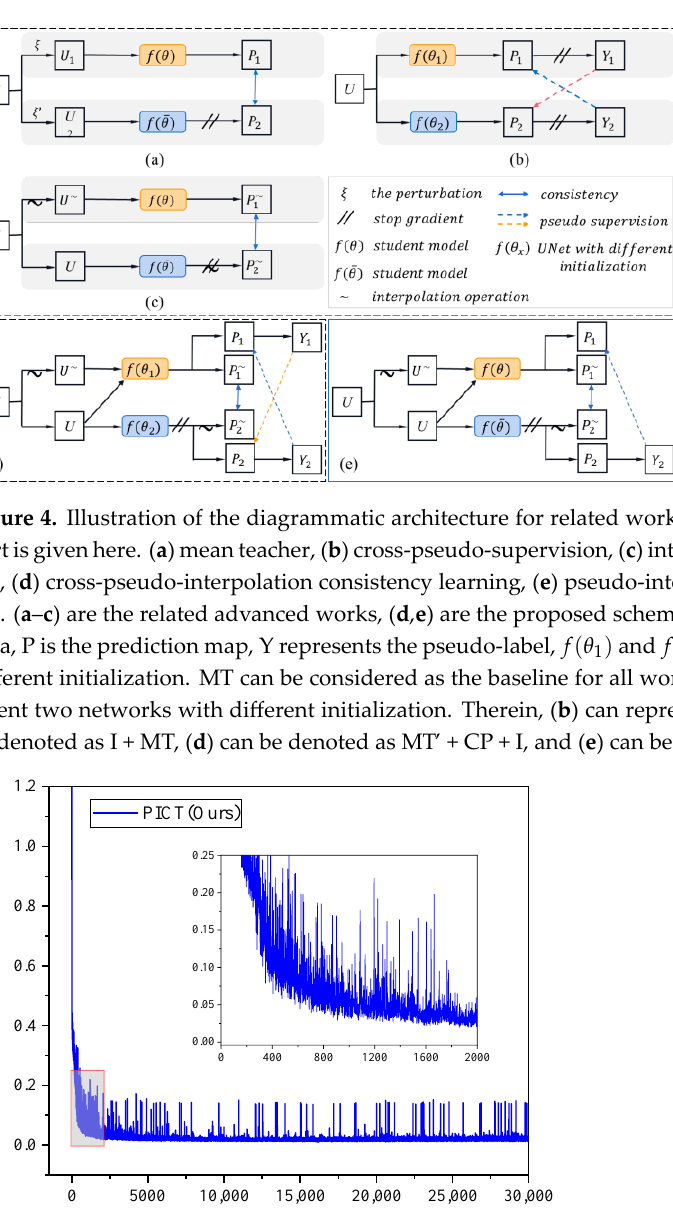
Figure 4. Illustration of the diagrammatic architecture for related works; only the semi-supervised part is given here. ( a ) mean teacher, ( b ) cross-pseudo-supervision, ( c ) interpolation consistency training, ( d ) cross-pseudo-interpolation consistency learning, ( e ) pseudo-interpolation consistency training. ( a – c ) are the related advanced works, ( d – e ) are the proposed schemes. U denotes the unla- beled data, P is the prediction map, Y represents the pseudo-label, 𝑓(𝜃 1 ) and 𝑓(𝜃 2 ) represent net- work with different initialization. MT can be considered as the baseline for all work. Here, MT’ is used to represent two networks with different initialization. Therein, ( b ) can represented by MT ’ + CP, ( c ) can be denoted as I + MT, ( d ) can be denoted as MT ’ + CP + I , and ( e ) can be denoted as I + MT + P.